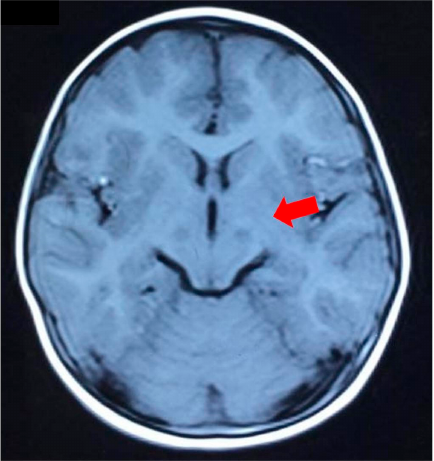
Figure 1. Brain MRI of our patient. MRI showed an abnormal signal shadow in the bilateral thalamus (red arrow).